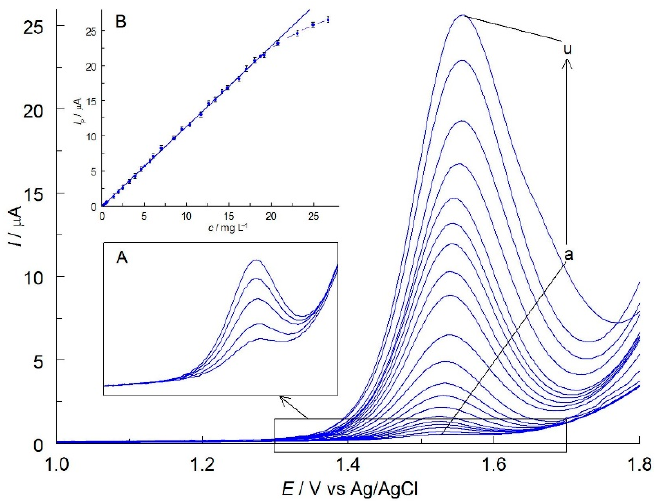
Figure 5. DPVs (d E = 50 mV) recorded on BDDE in C-PB solution (pH 5.6) containing different concentrations of MIT ranging from ( a ) 0.24–( u ) 20.74 mg L − 1 . Insets: ( A ) enlarging part of the main picture for small concentrations (0.24–0.98 mg L − 1 ); ( B ) calibration plot for MIT.